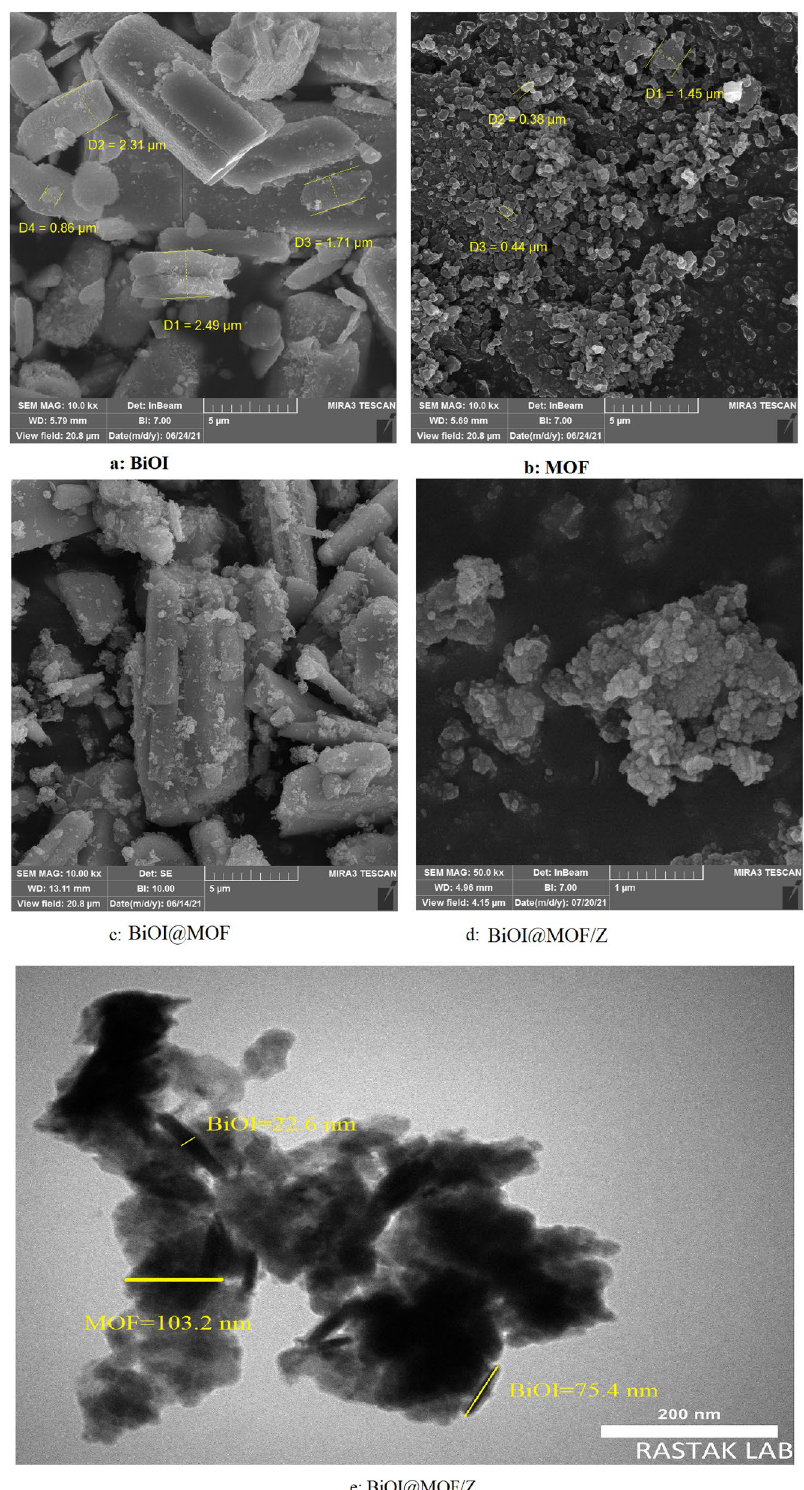
Figure 4. SEM images of ( a ) BiOI, ( b ) MOF, ( c ) BiOI@MOF, ( d ) BiOI-MOF/Z and TEM image of BiOI-